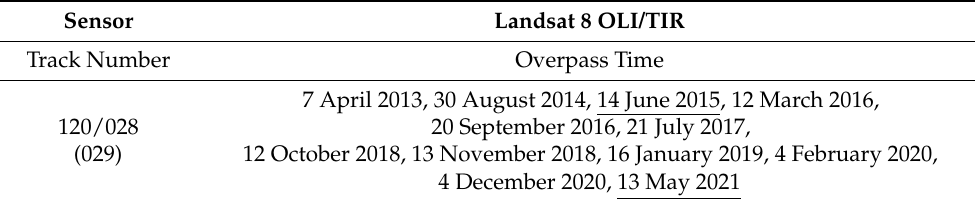
Table 1. The Landsat 8 images required for the study area and the overpass time for the acquired images. Sensor Landsat 8 OLI/TIR Track Number Overpass